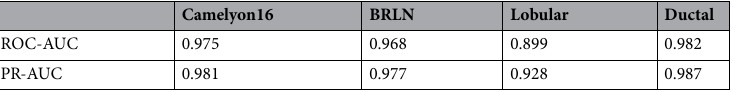
Table 2. PR and ROC AUC values based on softmax scores (single model) for each of the 4